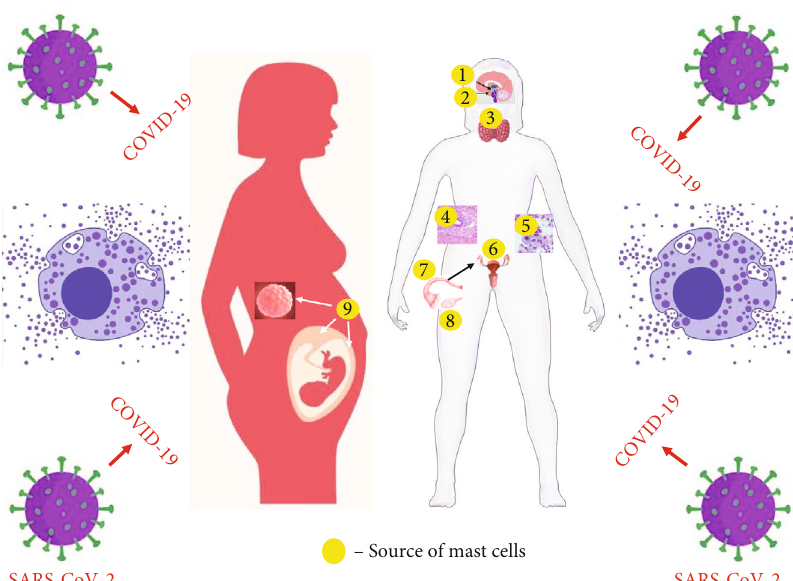
Figure 2: The potential sites of mast cell activation syndrome (MCAS) that may a ff ect female reproductive function. There are indications to believe that SARS-CoV-2 infection and related COVID-19 may produce release of MC mediators from MC sources within female reproductive organs and other related to reproduction organs, such as 1: hypothalamus; 2: pituitary gland; 3: thyroid gland; 4: endometrial tissue outside the uterus (endometriotic foci); 5: peritoneal fl uid; 6: uterus (endometrium, myometrium), 7: fallopian tube; 8: ovary; and 9: blastocyst, placenta, and decidua. Surprisingly, in majority of cases, histologic rationale for increased risk of MCAS (i.e., presence of mast cells in the respective organs) is not con fi rmed by pathophysiology (i.e., clearly proven relationship: MCAS ⟶ reproductive disorder), and so far, clinical data do not support that COVID-19 triggers MCAS in female reproductive system. See the main text (Section 4) for